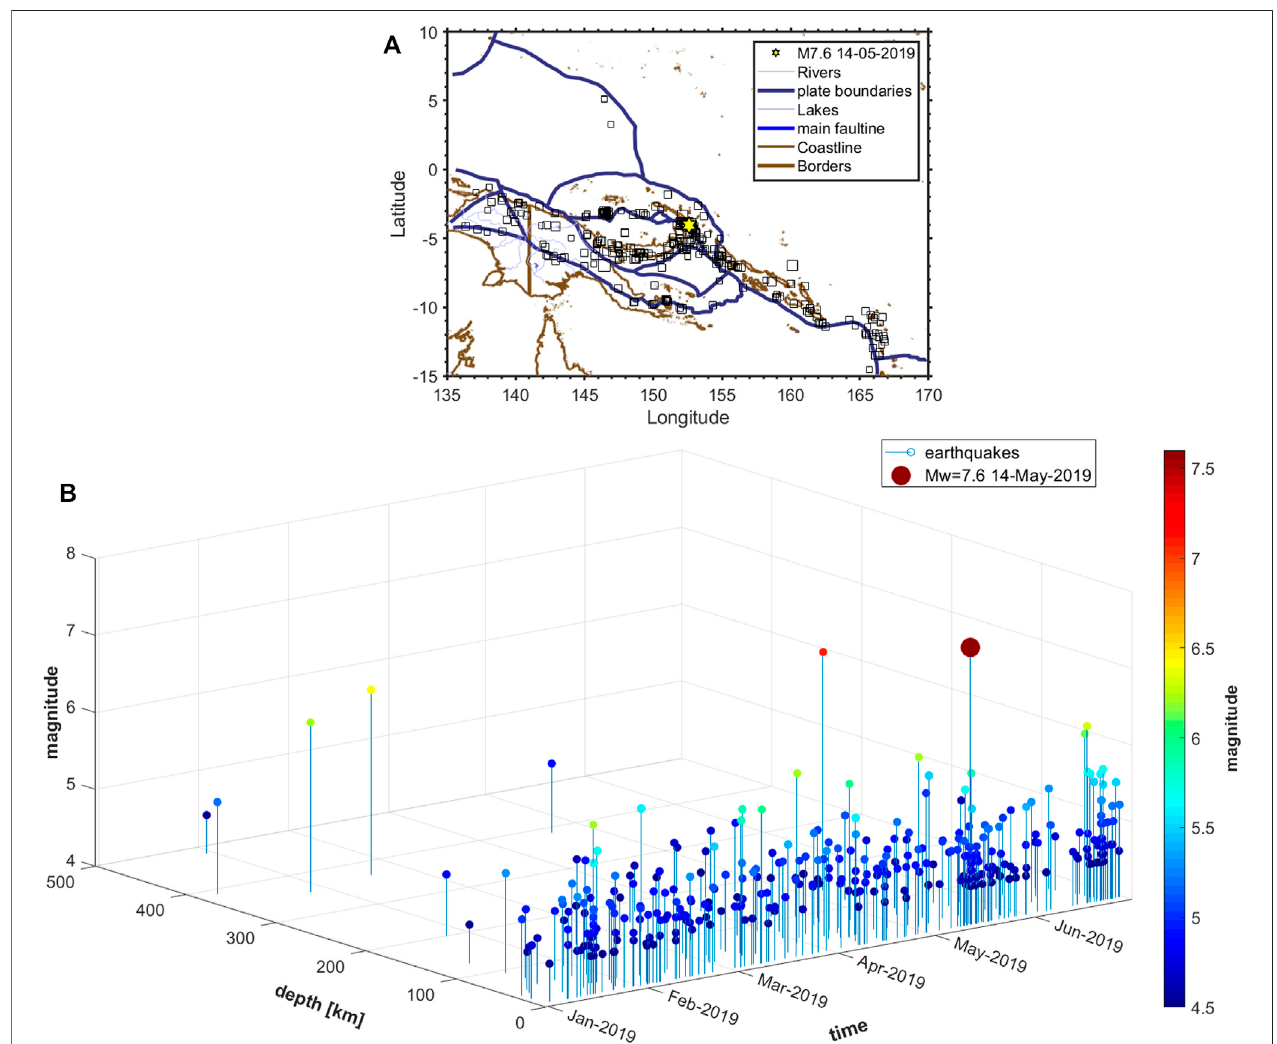
FIGURE 1 | Representation of the M4.5+ earthquakes that occurred inside the Dobrovolsky area of the Mw = 7.6 May 14, 2019 Papua New Guinea earthquake from January 01 to June 30, 2019 retrieved from USGS catalogue (https://earthquake.usgs.gov/earthquakes). (A) Geographical map of the seismic events with the geographical features and main faults. The epicenter is depicted by a yellow star. (B) Graph of the temporal, depth, and magnitude of the selected M4.5+ events. The main shock has been evidenced by the largest circle.